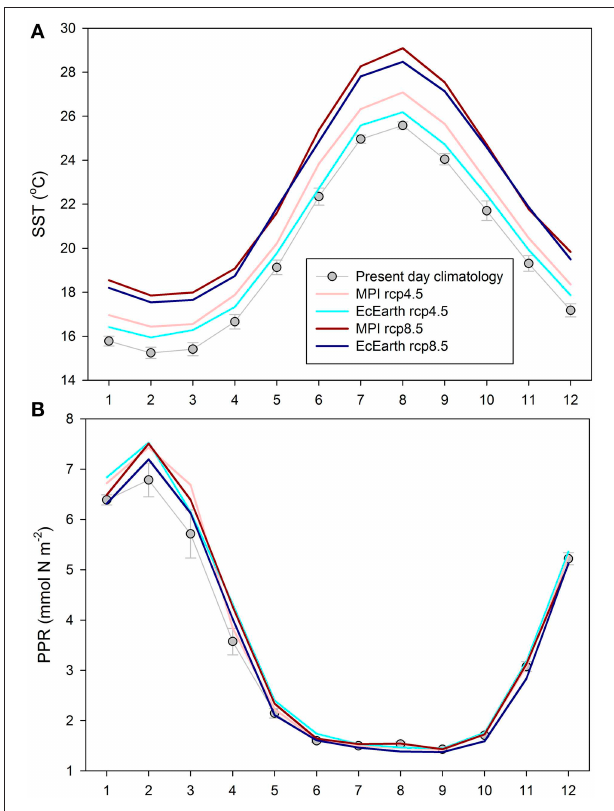
FIGURE 5 | Climatological cycles of (A) SST and (B) PPR at the beginning of the different runs (gray lines, 2015–2019) and at the end (2095–2099) of each scenario run. The errors bars indicate the dispersion between model runs for the beginning simulation period.